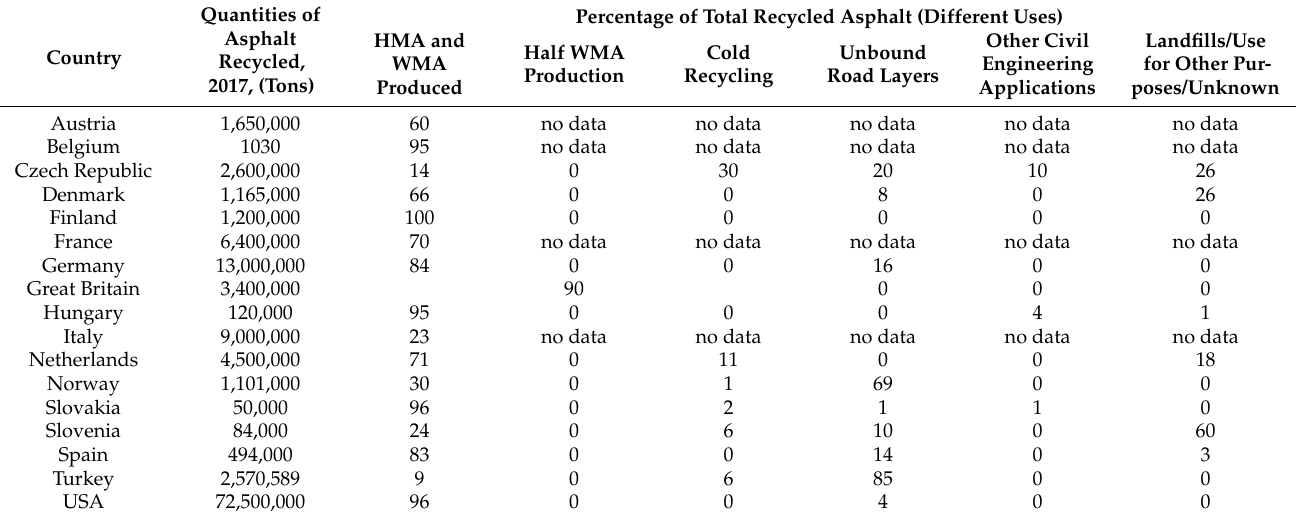
Table 1. Overview of the quantities of recycled asphalt in Europe and in the world, and its use [39].